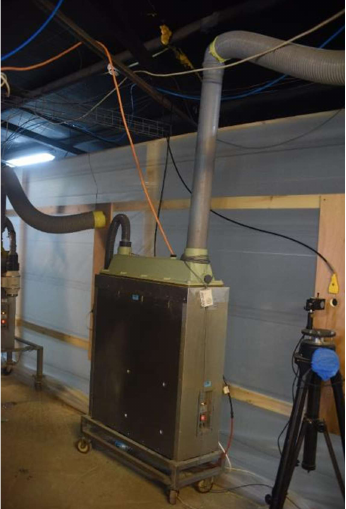
Figure 5. The fog-streaming machine. Electronics 2020 , 9 , x FOR PEER REVIEW